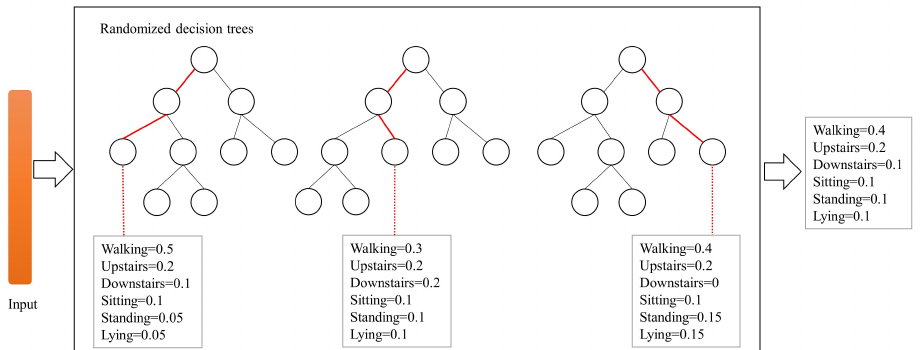
Figure 3. Class vector generation of the randomized decision trees. A probability vector is obtained from each decision tree and the final probability vector of randomized decision trees is jointly generated by all the decision